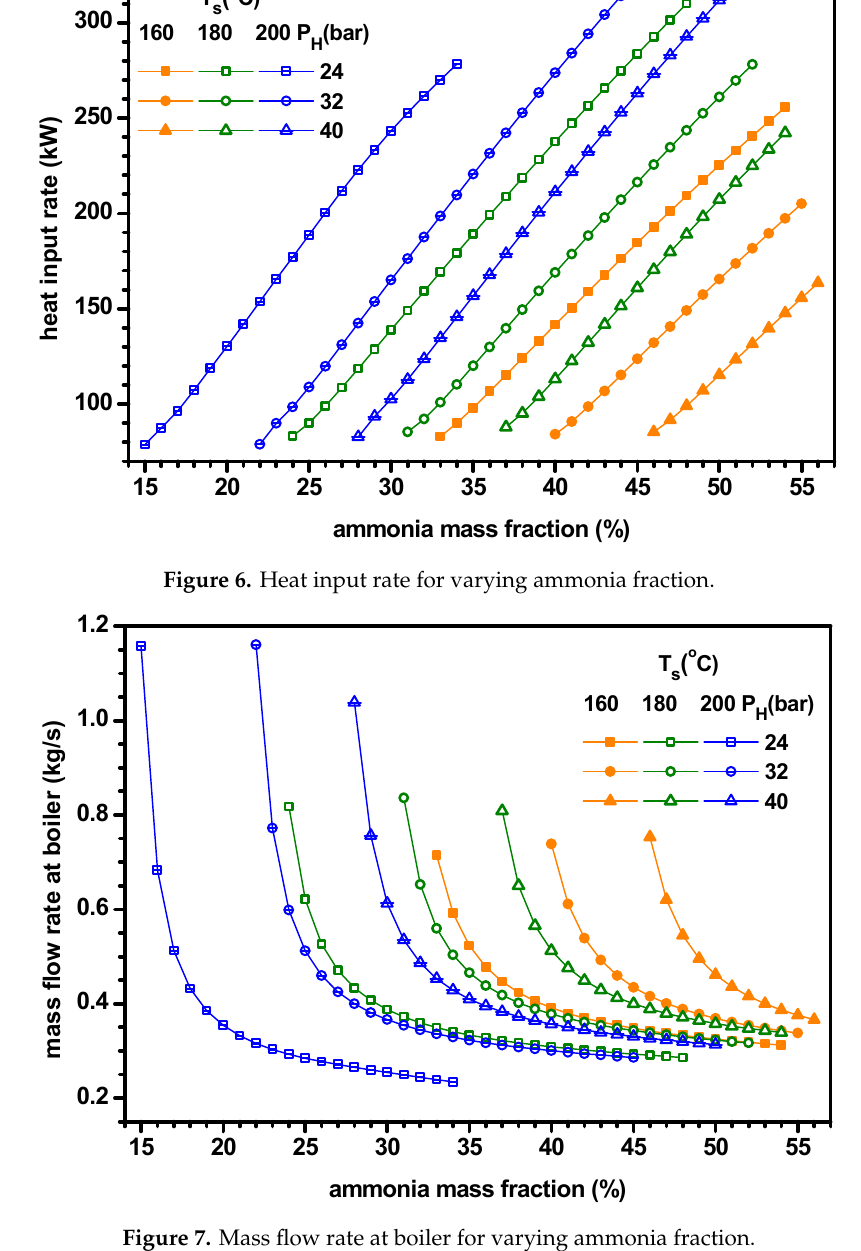
Figure 7. Mass flow rate at boiler for varying ammonia fraction.